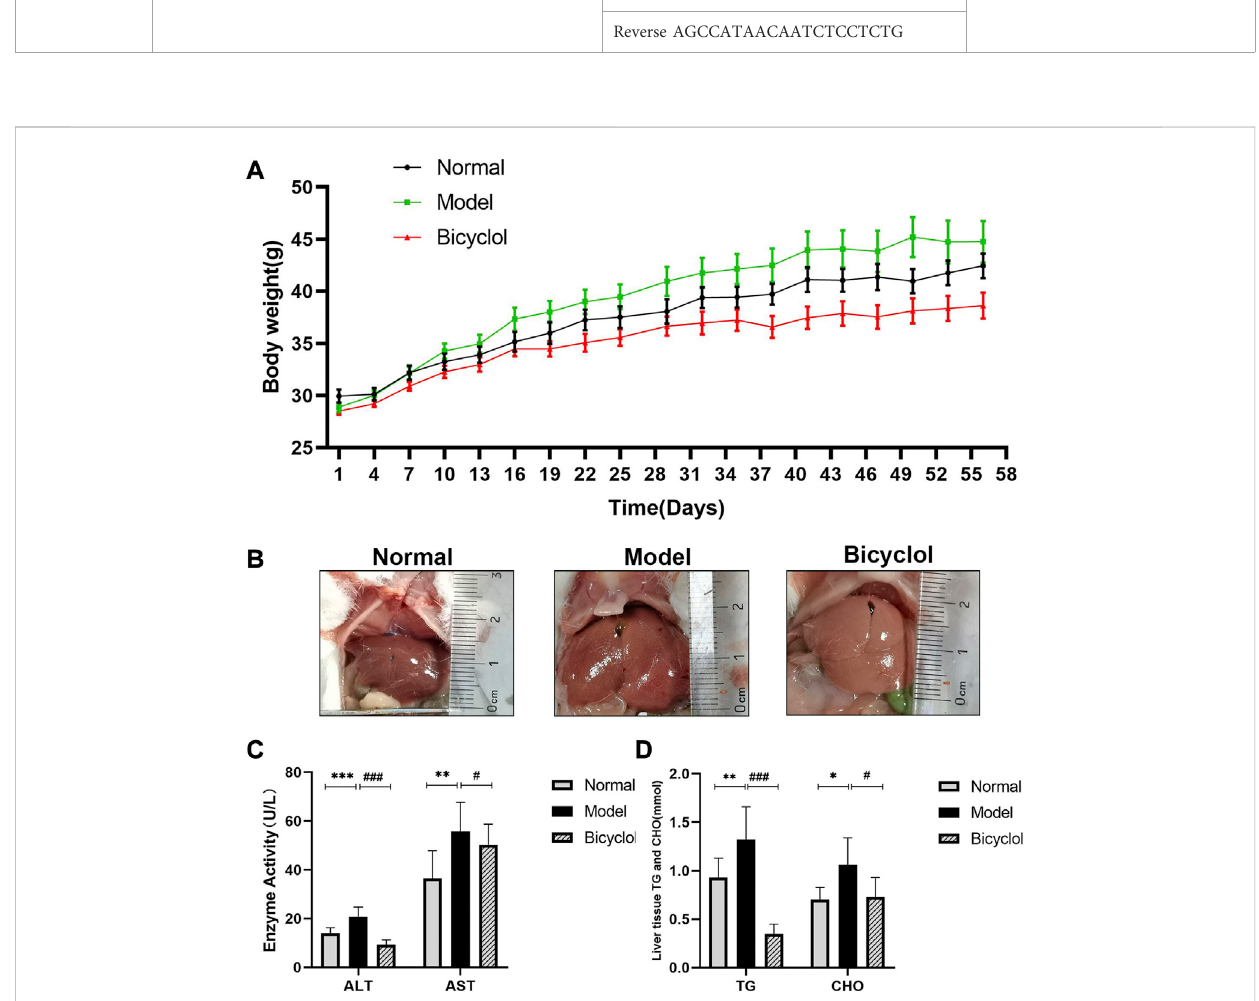
EffectsofbicyclolonbodyweightandbiochemicalindexesofmicefedwithHFD. (A) Changingofmiceweightduringfeedingperiodof8weeks( n =10). (B) Representativeimageofliver. (C) Analysesoflivertransaminase( n =9). (D) AnalysesofTGandCHOinlivertissues( n =9).* p < 0.05vsNormal,** p <